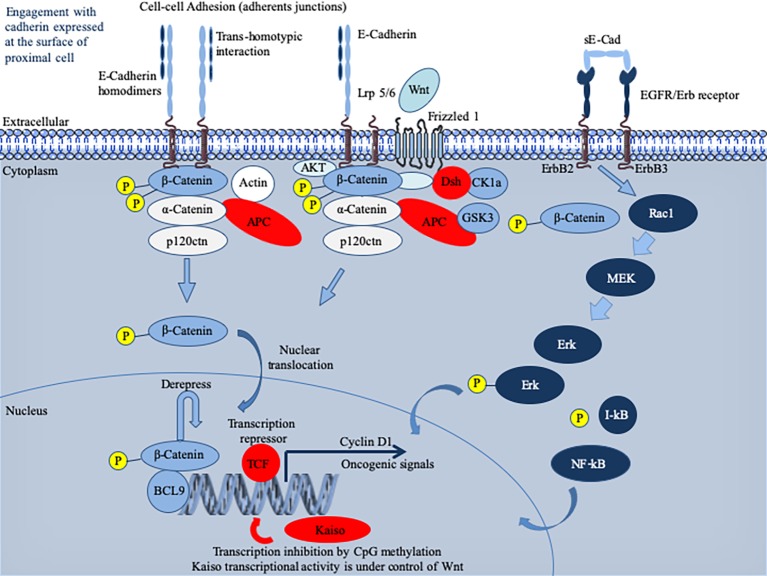
Schematic representation of the E-cadherin (E-cad) interactions and signaling pathway. Newly synthesized E-cad are transported from the Golgi apparatus to the cell surface where they are available to engagement in intercellular interactions. The model presented reflects evidence that E-cad homodimers are involved in adherens’ junctions. Loss of E-cad expression in epithelia results in loosening of intercellular contacts. E-cad regulates the intracytoplasmic pool of α-cat and β-cat acts as a signal transducer molecule in response to upstream Wnt pathway (Fagotto, 2013). Briefly, the Wnt pathway is initiated by the binding of an extracellular Wnt ligand to a surface receptor composed of Frizzled, a seven transmembrane (7TM) molecule and low-density lipoprotein receptor-related protein 5 or 6 (Lrp5/6). As a result of the Wnt pathway activation that mobilizes several intracytoplasmic molecules (including disheveled, adenomatous polyposis coli – APC binds axin and β-cat and inhibits glycogen synthase kinase 3β – and ΑΚΤ kinase) (Fang et al., 2007; MacDonald et al., 2009; Wu et al., 2009), free cytoplasmic β-cat destruction is inhibited and β-cat translocates to the nucleus. Once in the nucleus, β-cat activates expression of genes such as cyclin D1 or c-MYC, otherwise repressed by the T cell factor/lymphoid enhancer factor (TCF/LEF) (Gumbiner, 1995). To achieve trans-activation, β-cat recruits a range of nuclear co-factors including CBP/p300, Brg-1, and the adaptor protein BCL9 (Hecht et al., 2000; Barker et al., 2001; Kramps et al., 2002; de la Roche et al., 2008). Cad-free p120ctn can also trigger the nuclear translocation of β-cat through its association with the Vav2 small GTPase and activation of JNK kinase (Wu et al., 2009; Valls et al., 2012). It is worth noting that TCF/LEF-binding sites have been identified in the CDH1 gene promoter, which may permit a feedback control loop where β-cat might activate E-cad mRNA production (Huber et al., 1996). E-cad expression can also be regulated by microRNAs (not shown), such as miR200, which favor E-cad mRNA expression (Gregory et al., 2008). Cells with greater E-cad abundance can sequester and thereby inhibit the ability of β-catenin to translocate to the cell nucleus to derepress the activity of its DNA-binding factor TCF/LEF. When unable to engage in interactions, E-cad enters an endocytic uptake and is directed to early sorting endosomes from which they can either be recycled back to the cell surface by recycling endosomes or routed from late endosomes to proteasome where they undergo degradation (for details see the reviews by (Niessen et al., 2011; Nava et al., 2013; McCrea et al., 2015). During infection with bacteria, the pathogen can either regulate the expression of the CDH1 gene and thereby the cell-surface abundance of E-cad or trigger the catalytic cleavage of E-cad. This can result in the release of a cytosolic pool of β-catenin acting as a downstream effector in the Wnt signaling pathway and induction of oncogenic signals. The sE-cad can associate with intact E-cad present on other cells to alter Cad-dependent cellular behavior. It can also interact with the EGFR molecule to activate the ERK signaling pathway.